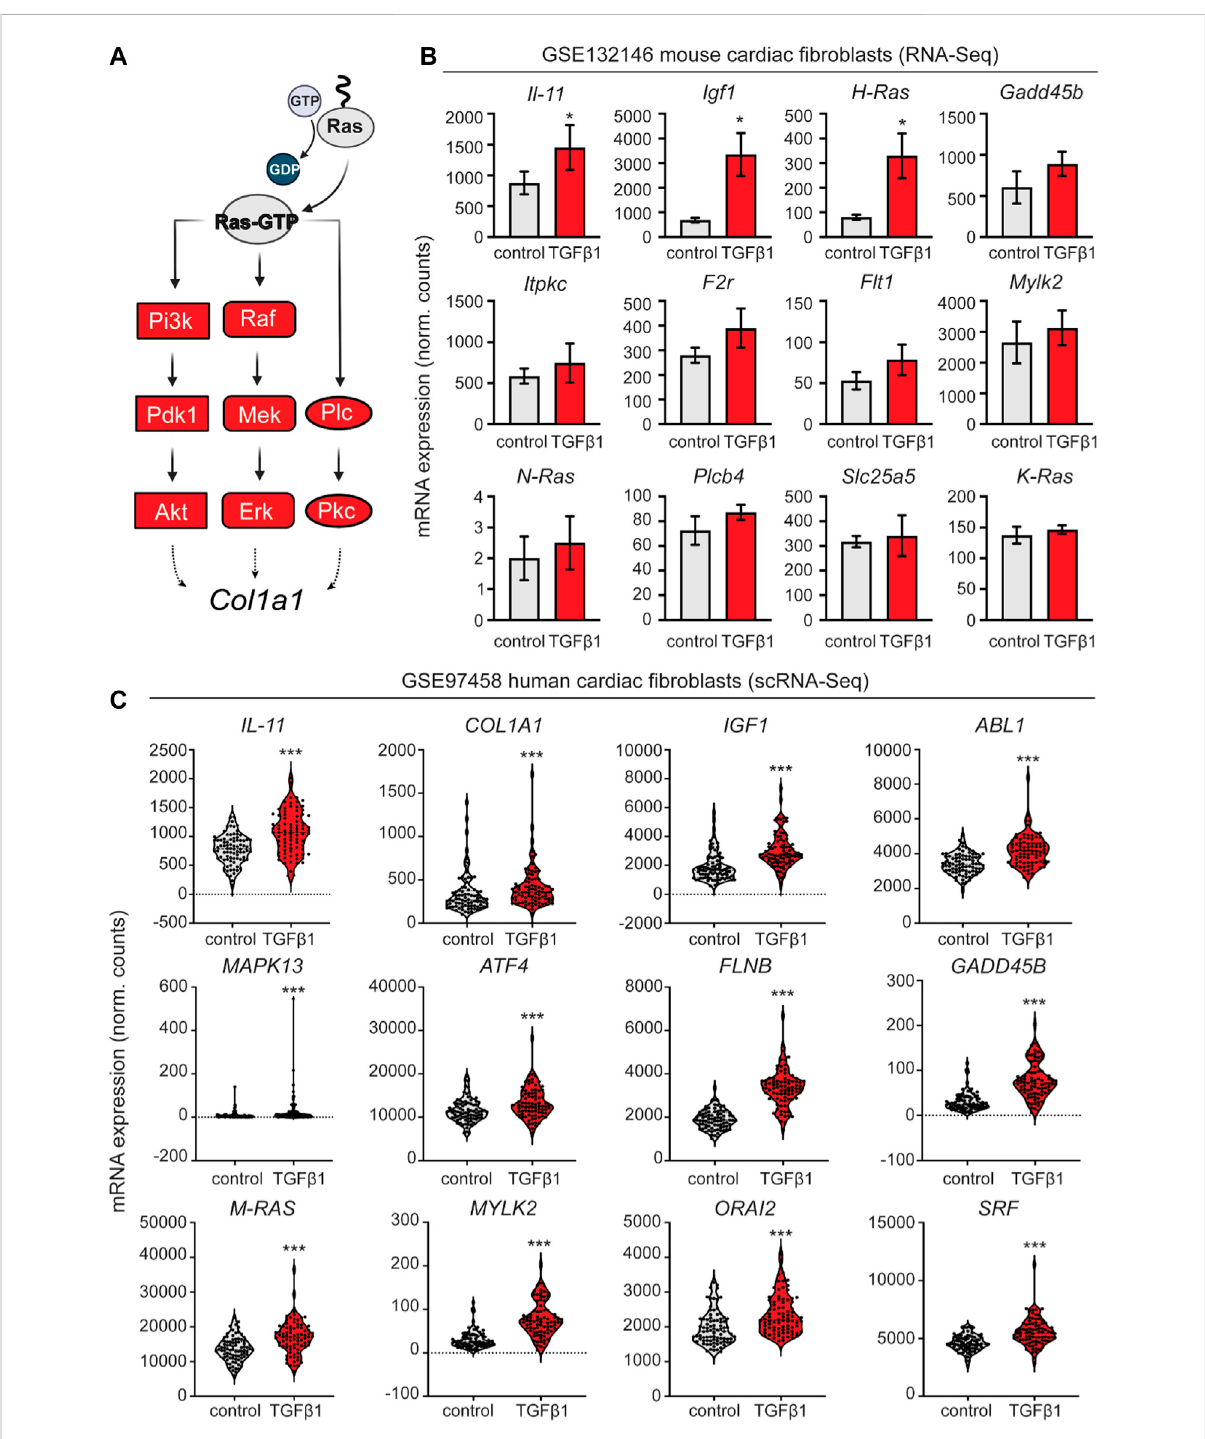
FIGURE 1 Retrospectiveanalysisoftranscriptomicdatafrommouseandhumancardiac fi broblastsactivatedwithTGF- β 1. (A) schematicrepresentationof theactivatednodesoftheRassignalingpathway. (B) Expressionanalysisofthemousecardiac fi broblastsdatasetGSE132146showingtranscriptional levels of pro- fi brotic and RAS pathway-related genes (*, p < 0.05; **, p < 0.01; ***, p < 0.001 compared to control). (C) Violin plots showing pro- fi brotic and RAS pathway related genes derived from a retroactive analysis of GSE97458 generated from single-cell RNA-seq of serum-free cultured human cardiac fi broblasts activated with TGF- β 1 (*, p < 0.05; **, p < 0.01; ***, p < 0.001 compared to